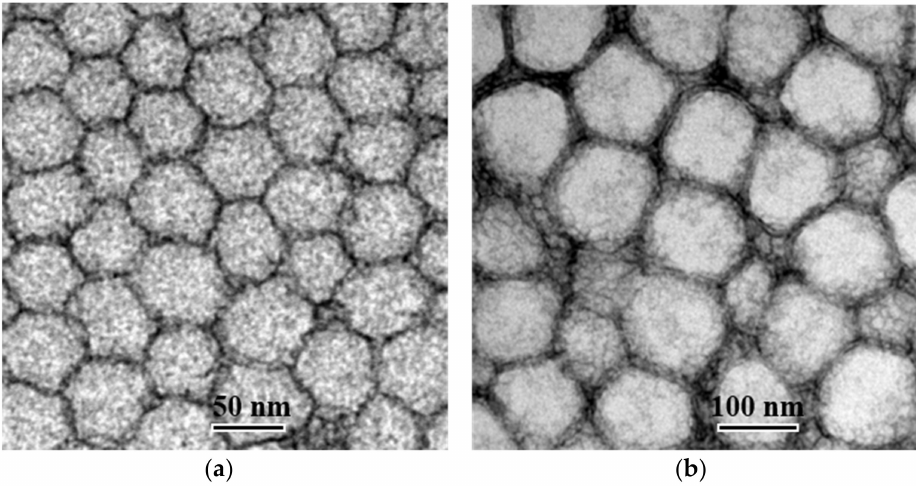
Figure 4. Blanks NE 1 ( a ) and NE 2 ( b ) under transmission electron microscopy.